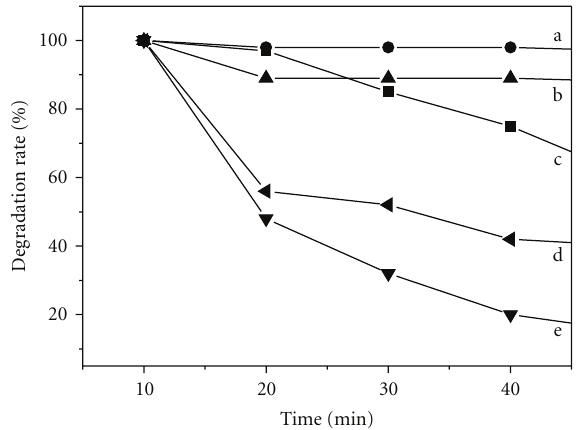
Figure 6: Normalized Curve shows E ff ect of di ff erent light sources, (a) in presence of Fe 3 O 4 in dark (b) in presence of Fe 3 O 4 @Au in dark (c) in presence of Fe 3 O 4 @Au in sun, (d) in presence of Fe 3 O 4 in UV lamp, and (e) in presence of Fe 3 O 4 @Au in UV lamp.